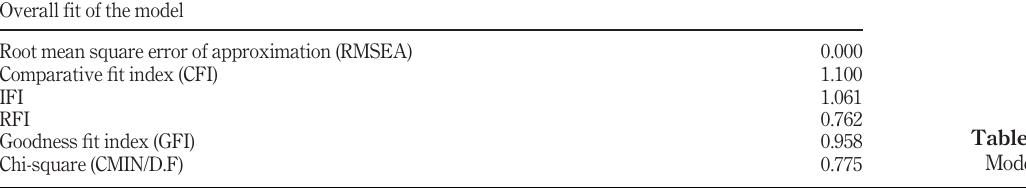
Overall fit of the